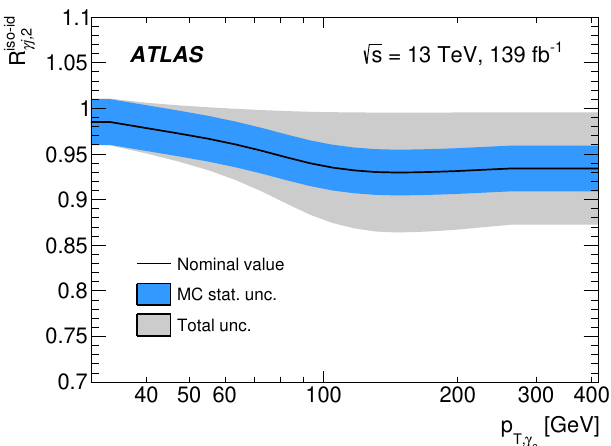
for the isolation-identification correlation, for jets misidentified Figure 6. Correction factor R iso − id γj, 2 as photons. The nominal value is indicated in black, and is the average of the values obtained from a data validation region and a γj MC sample. The blue band corresponds to the simulation statistical uncertainty, and the grey band shows the total uncertainty, taking into account half of the difference between the MC and data